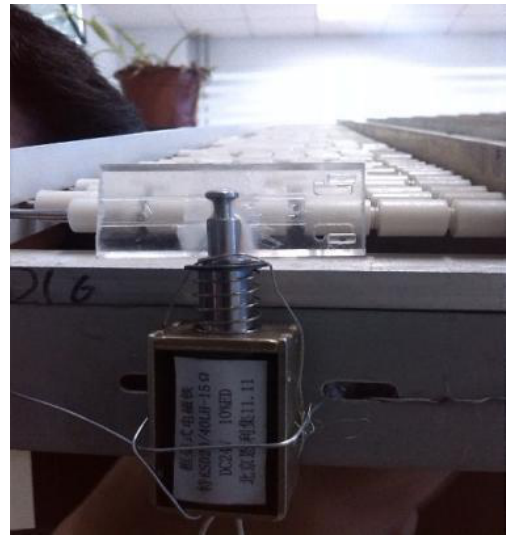
Figure 5. Simple drug delivery mechanism.